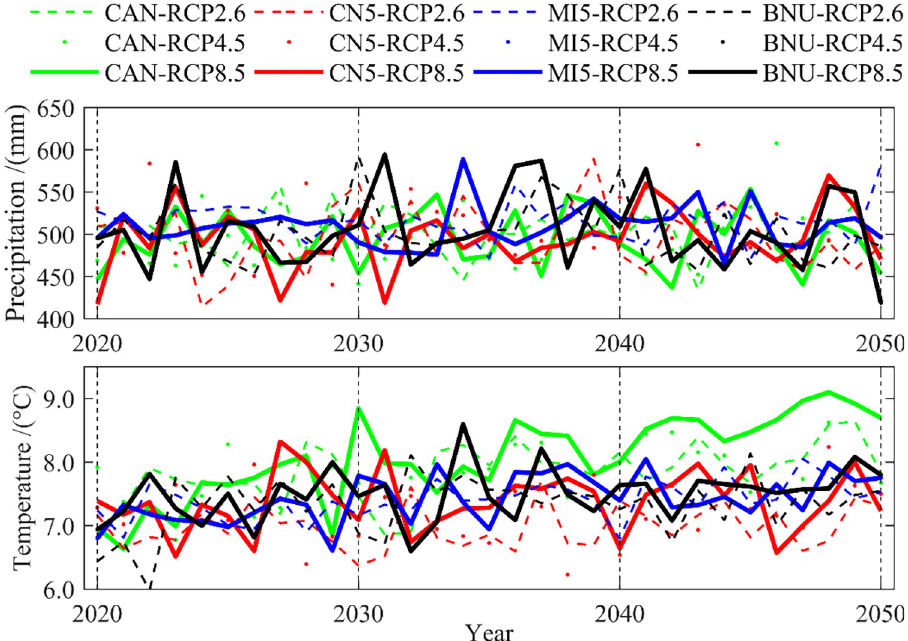
Fig 5. Temporal variation of precipitation and temperature in